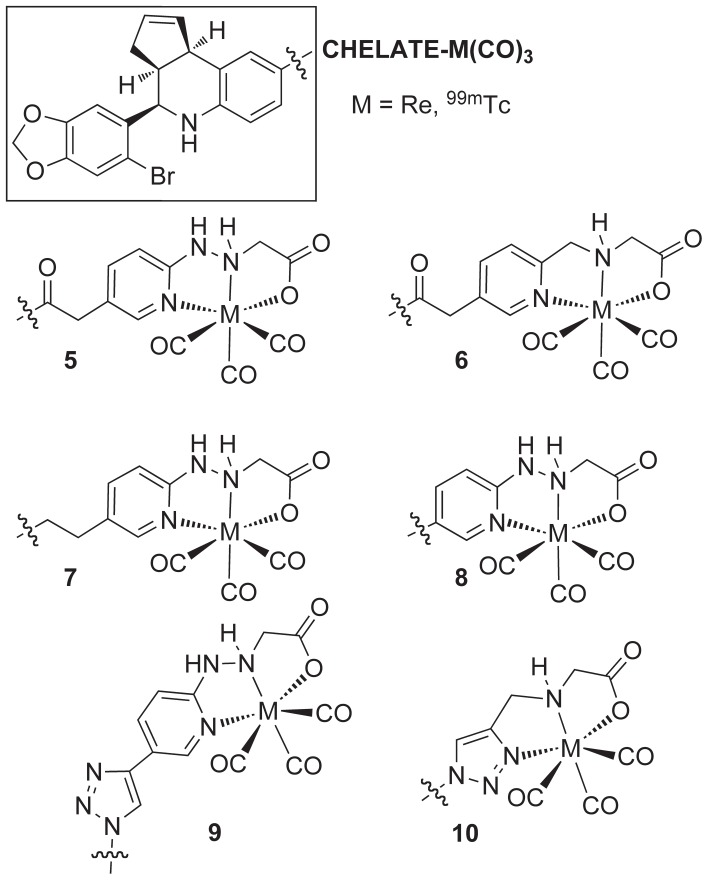
Structures of GPER-targeted organometallic M(CO)3
+ chelates (M = Re, 99mTc).